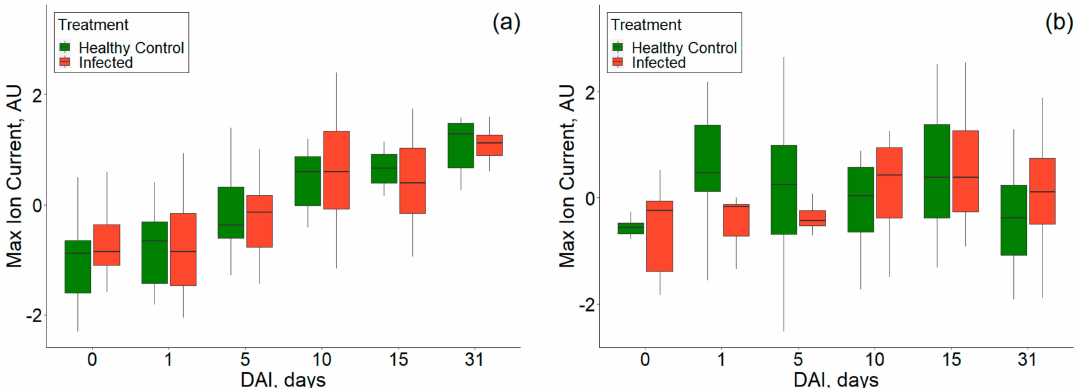
Figure 15. Ion current at 74% of the dispersion field and compensation voltage of − 1.31 Volts showing the temporal progression of healthy and P. ultimum inoculated treatments for ( a ) experiment-3 and ( b )